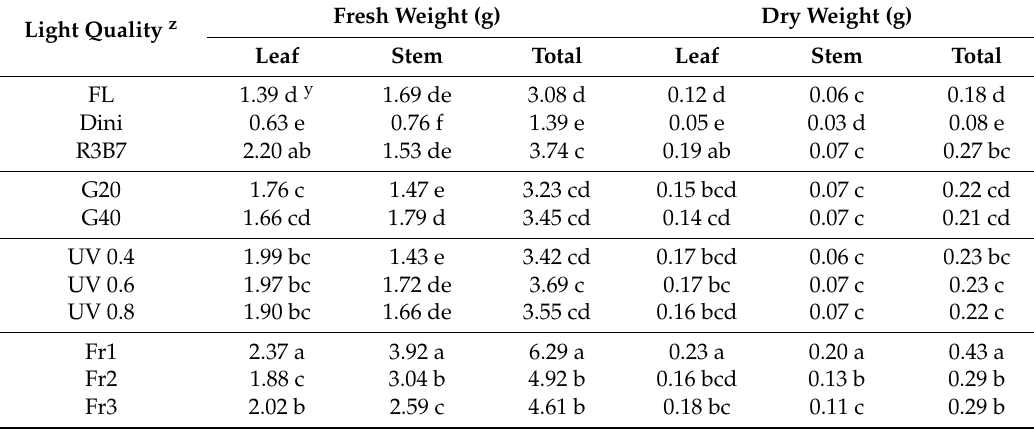
Table 2. The fresh and dry weights of leaves and stems of ‘Mini Chal’ tomato ( Solanum lycopersicum L.) affected by different light qualities measured 21 days after start of